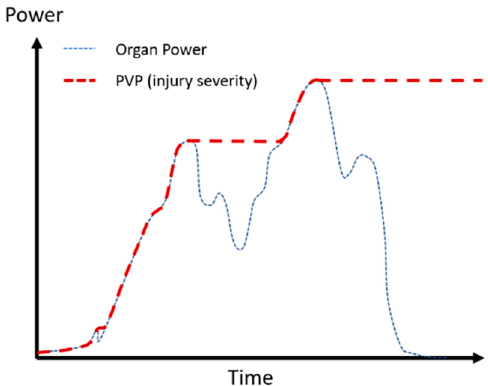
Figure 4. Power goes up and down, while trauma (represented by PVP) continues to increase [36]. PVP [12,33] is derived using the Clausius–Duhem inequality, which is from the rate-dependent form of the second law of thermodynamics [37], illustrated in Equation (1).